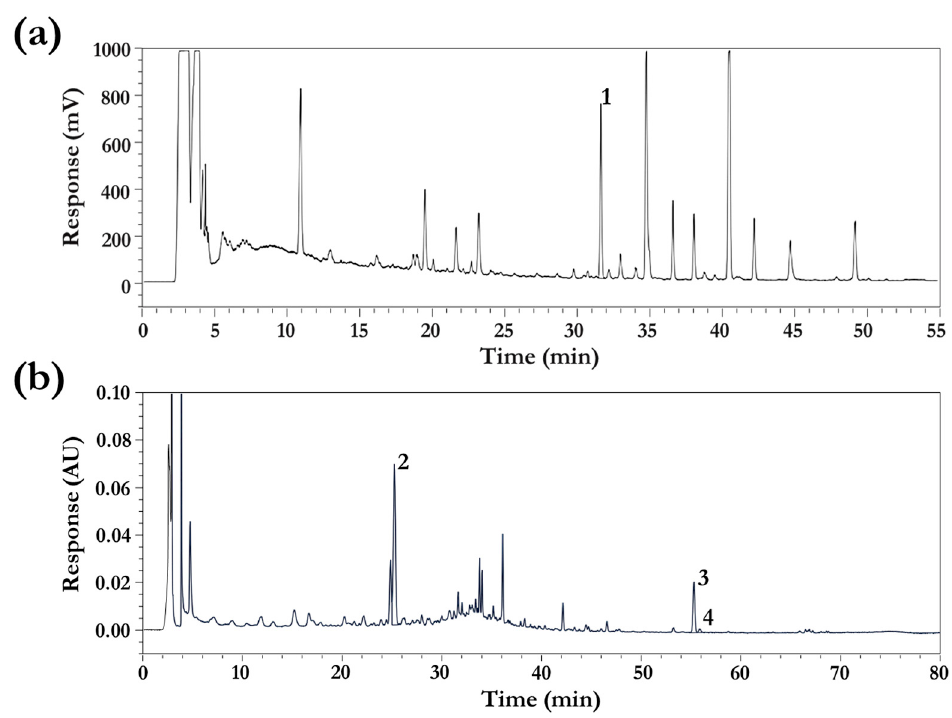
Figure 2. The chromatogram of DBT analysed using ( a ) HPLC ‐ ELSD and ( b ) HPLC ‐ PDA. 1 astragaloside IV, 2 ferulic acid, 3 ligustilide, 4 n ‐